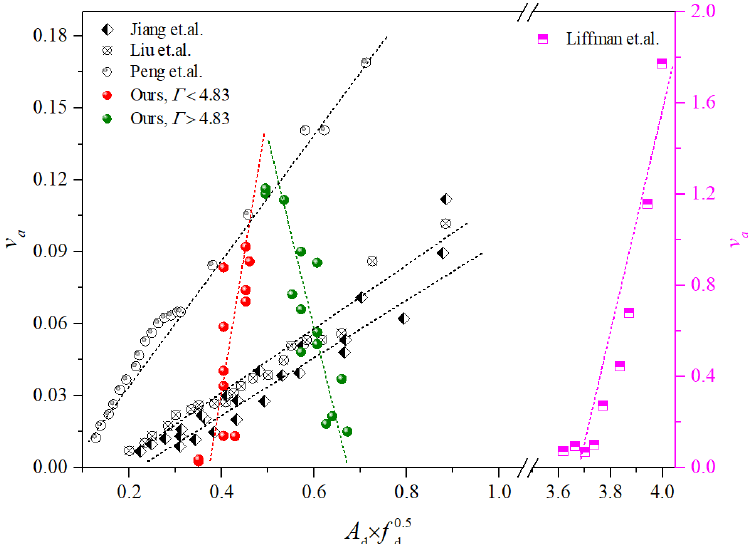
Figure 12. Response of v a to A